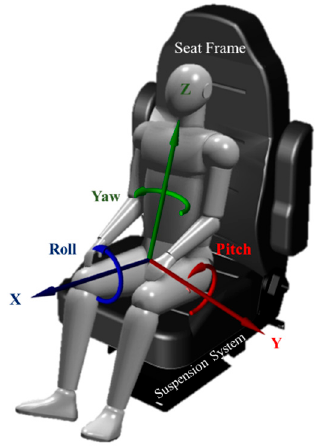
Figure 2. Whole body vibration of the seated human body.